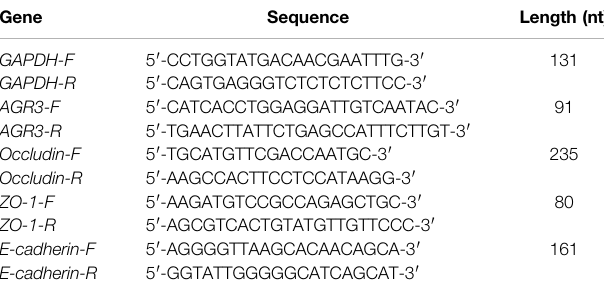
TABLE 1 | RT-PCR primers.